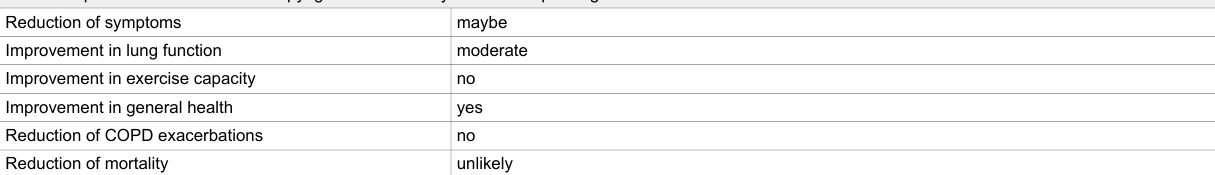
Table 6: Criteria for new therapeutic approaches: bronchoscopic lung volume reduction. No therapy available